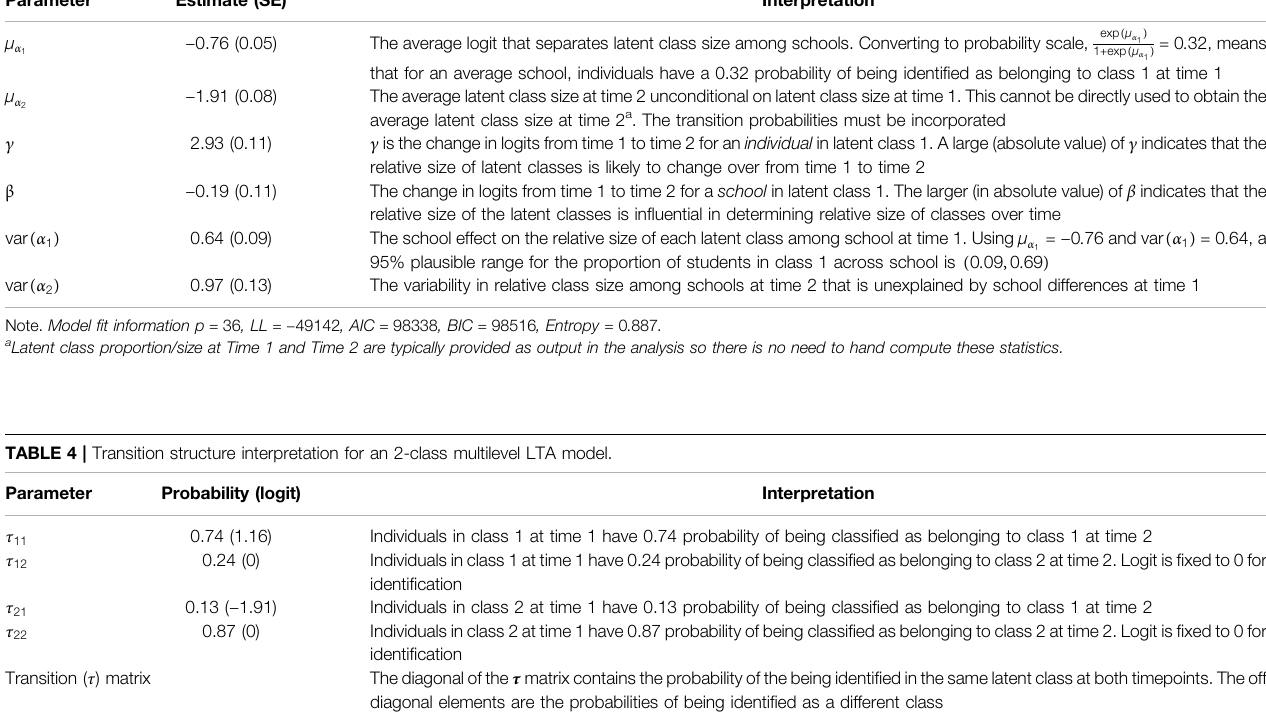
TABLE 3 | ECLS-K 2-class multilevel LTA model of social rating scale results and interpretation. Parameter Estimate (SE)